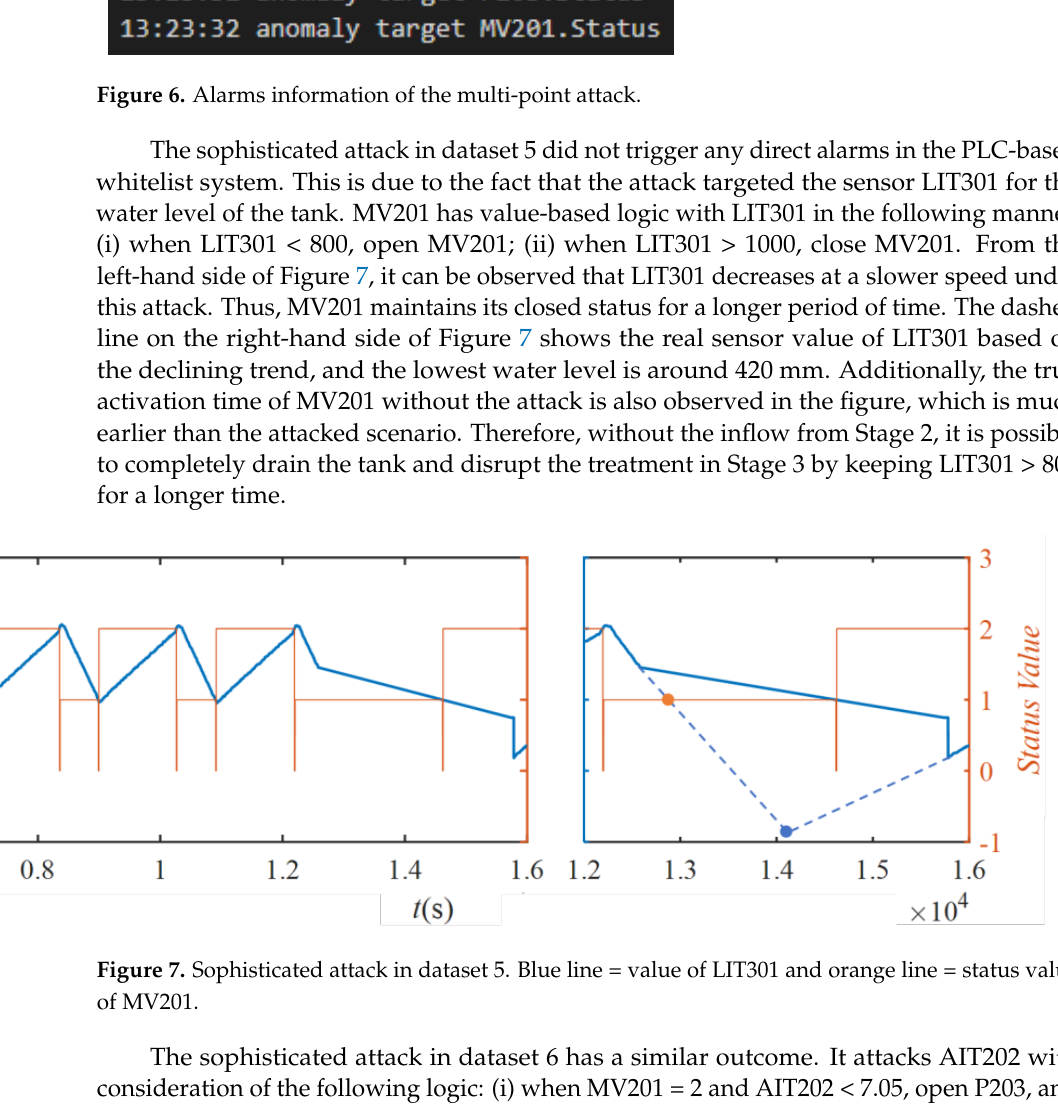
Figure 6. Alarms information of the multi-point attack.